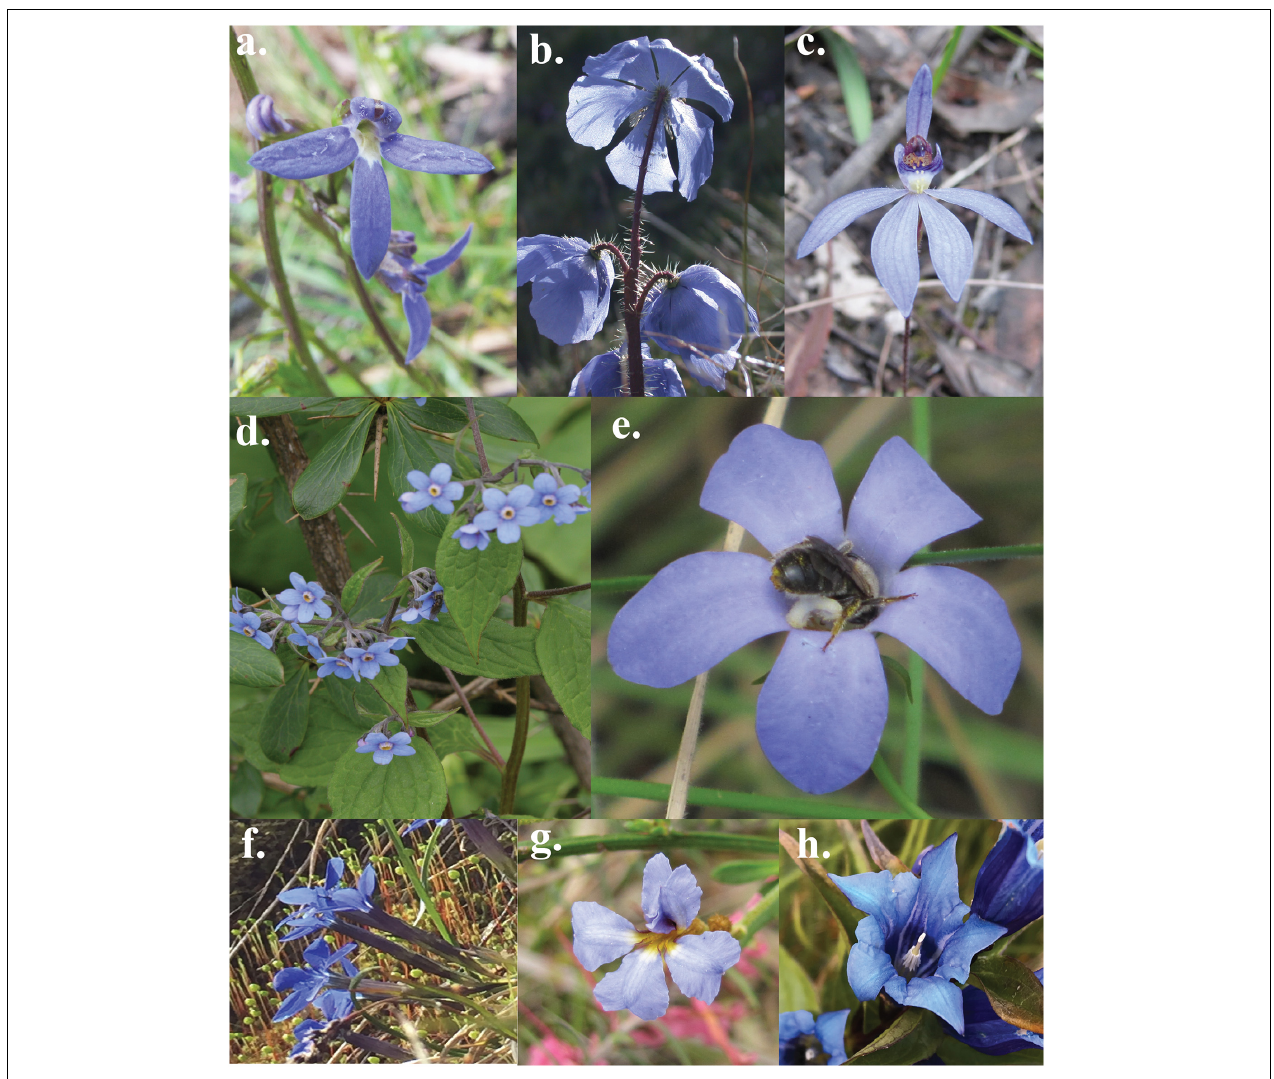
FIGURE 1 | Example of some flowers perceived as blue by a human observer: (a) Lobelia rhombifolia , (b) Meconopsis horridula , (c) Cyanicula caerulea , (d) Hackelia uncinata , (e) Wahlenbergia gloriosa , (f) Gentiana bavarica , (g) Dampiera stricta , and (h) Gentiana asclepiadea (Image Credit: Anke Jentsch, Mani